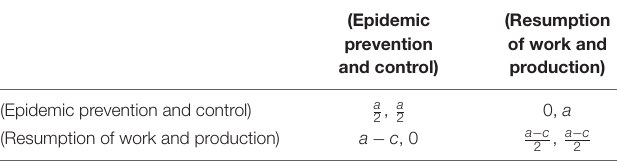
TABLE 2 | The adaptability matrix of the two-strategy game.